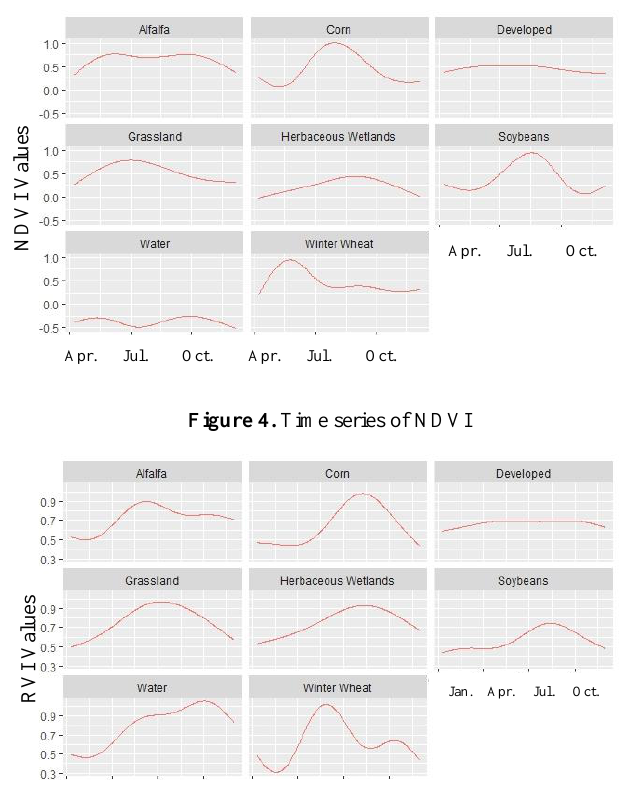
Figure 5. Time series of